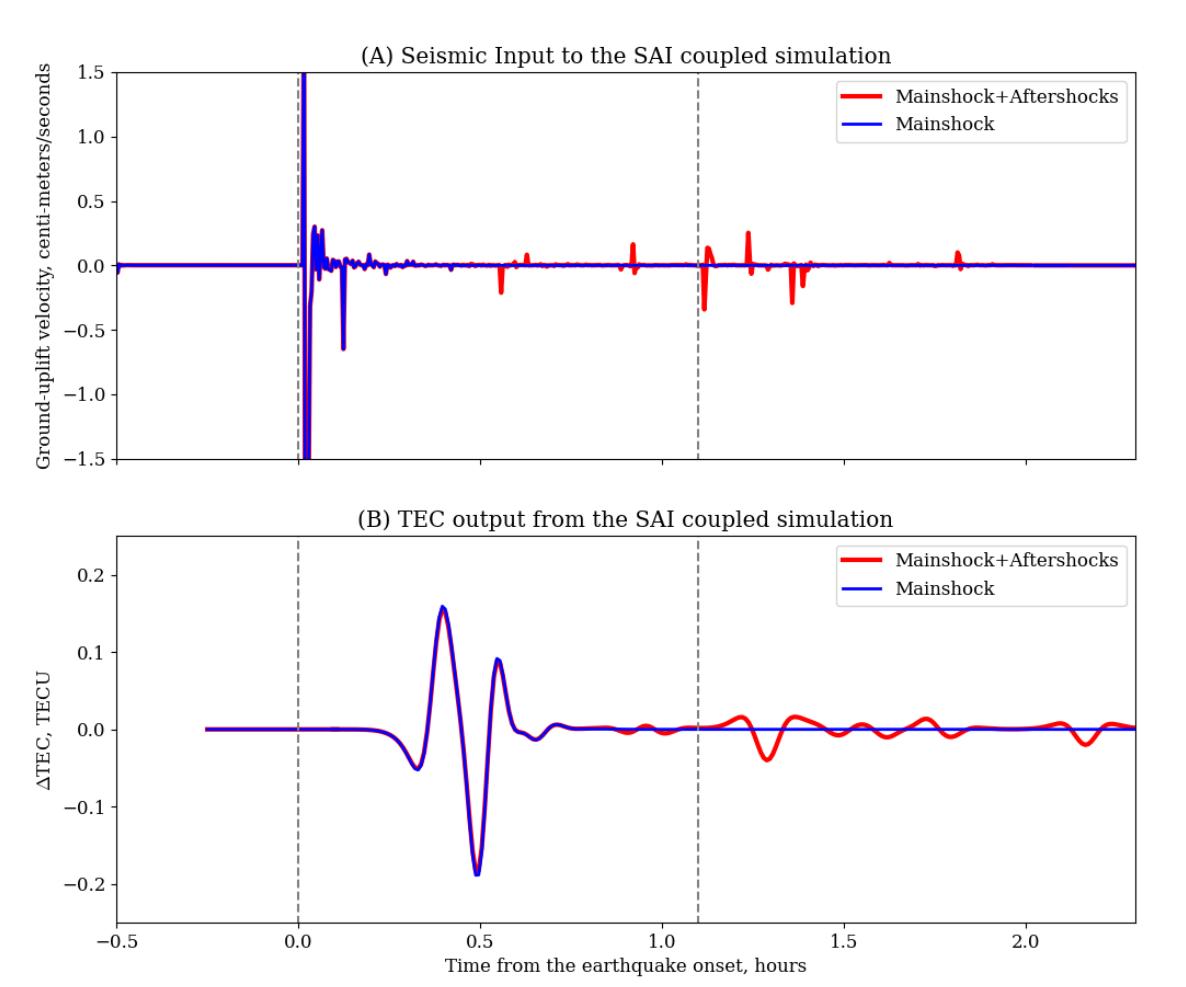
Figure A3. Simulation results from the SAI coupling model: ( A ) the ground vibration at the epicenter with and without the aftershocks. ( B ) simulated ∆ TEC with and without